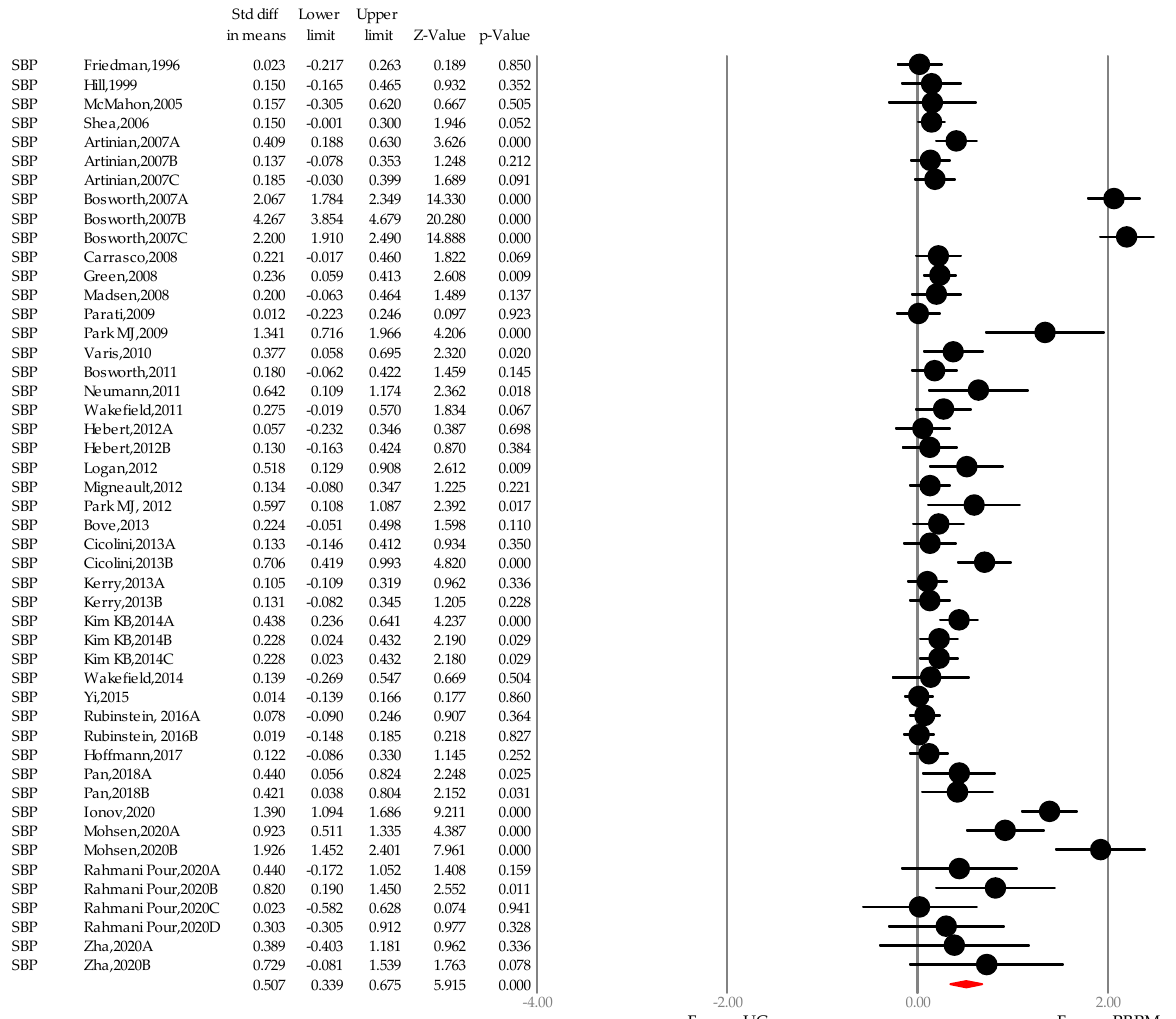
Outcome Author (year) (ref.)